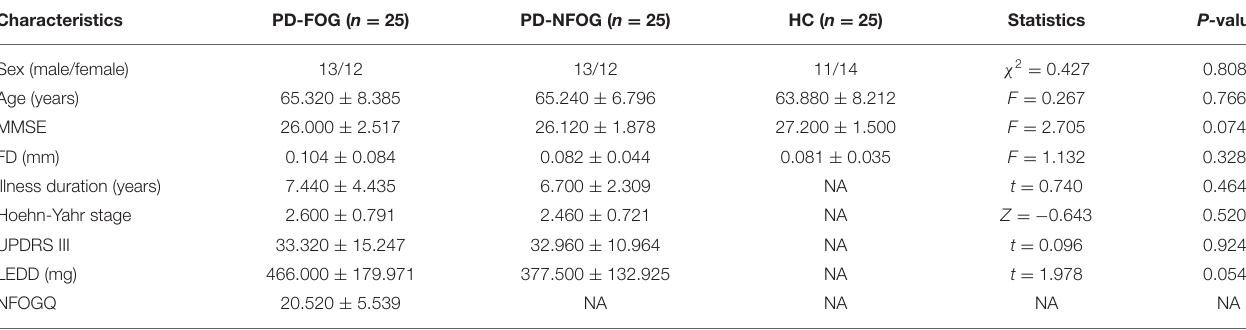
TABLE 1 | Demographic and clinical